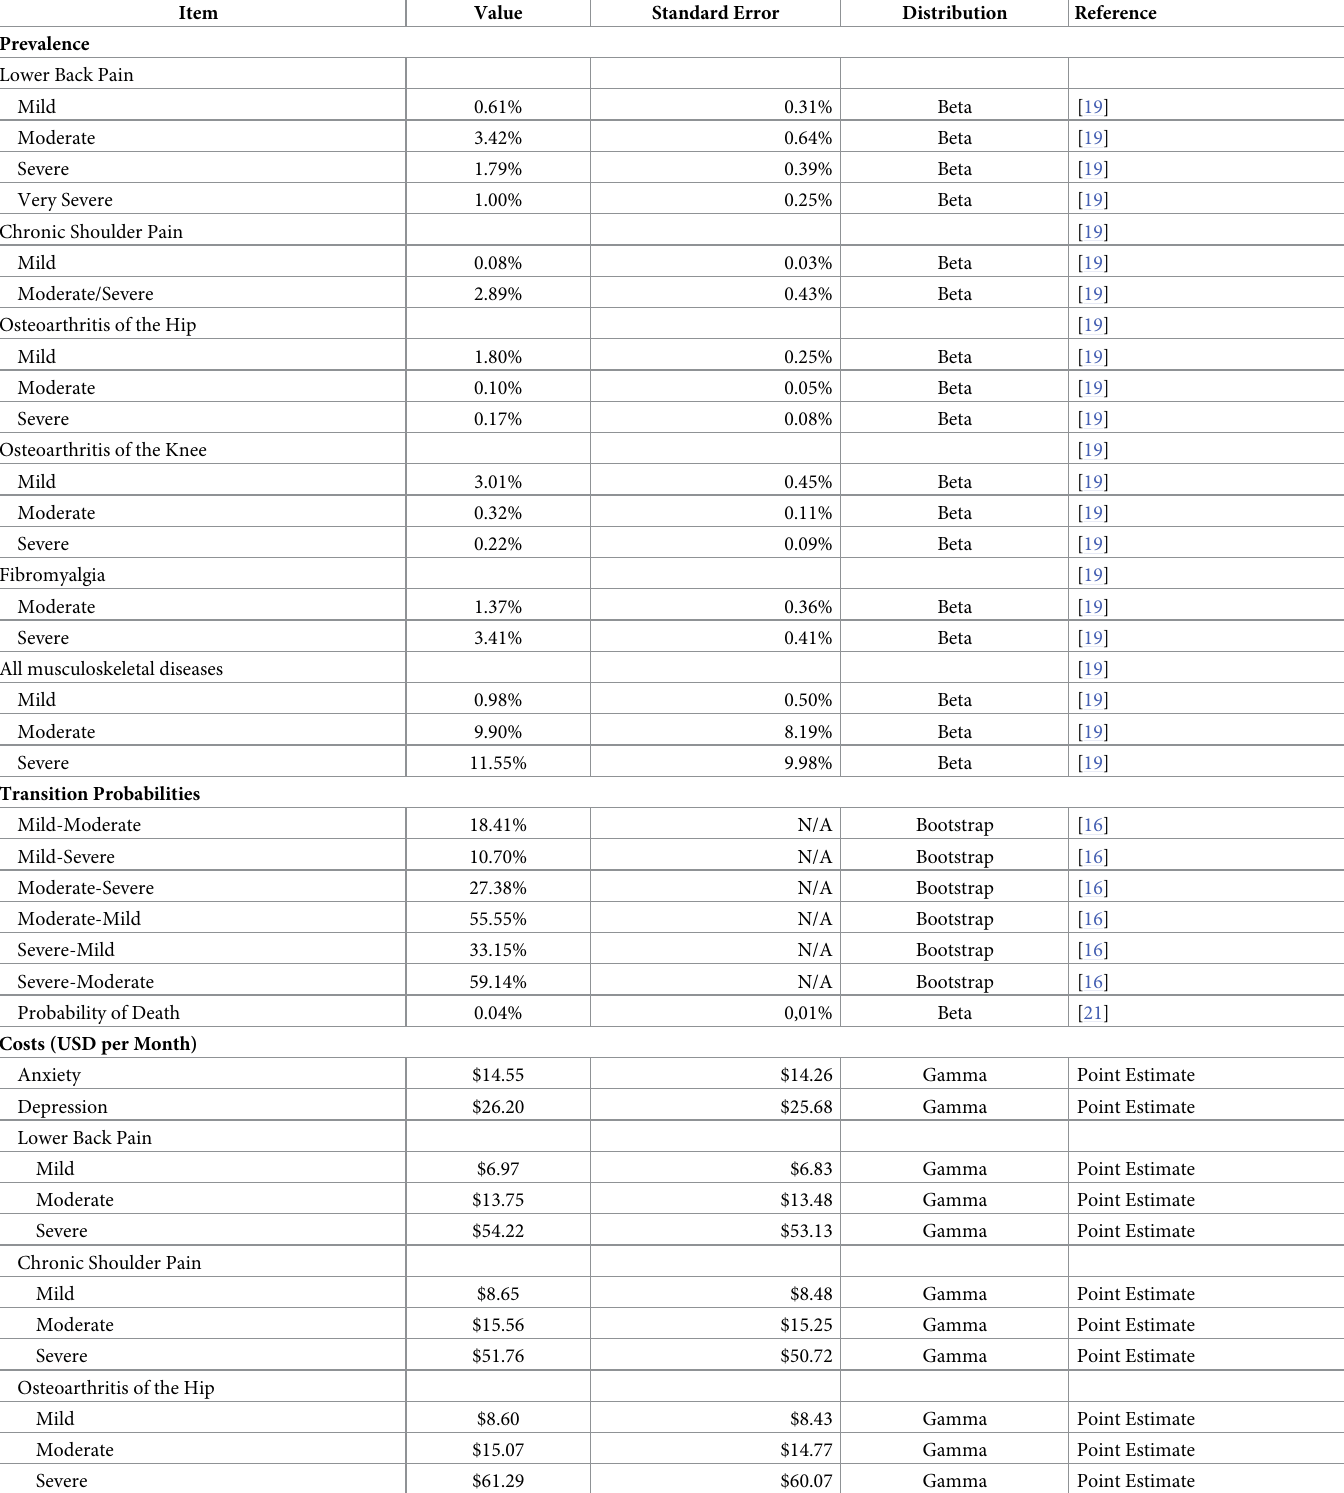
Table 1. Model parameters and parametric